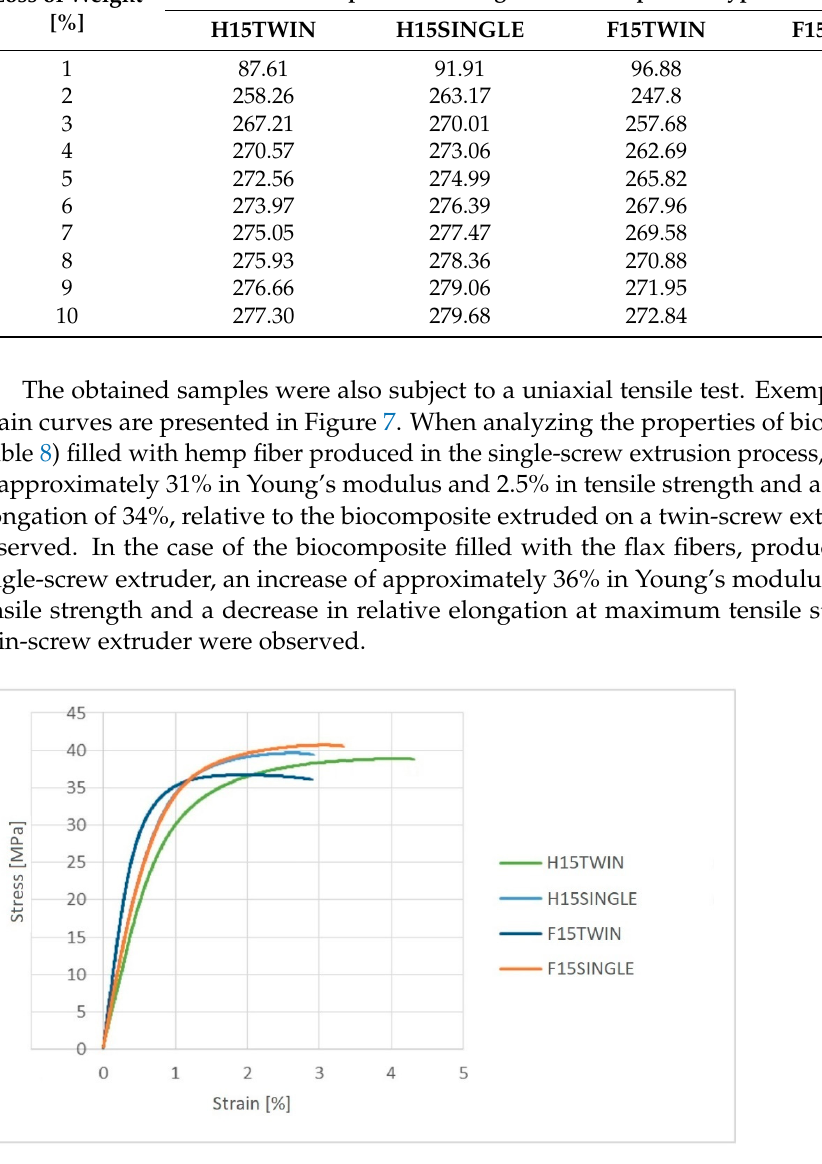
turn, in the area B, i.e., the gripping part of the dog-bone shaped sample, the hardness values ranged from 78 to 85 N/mm 2 .